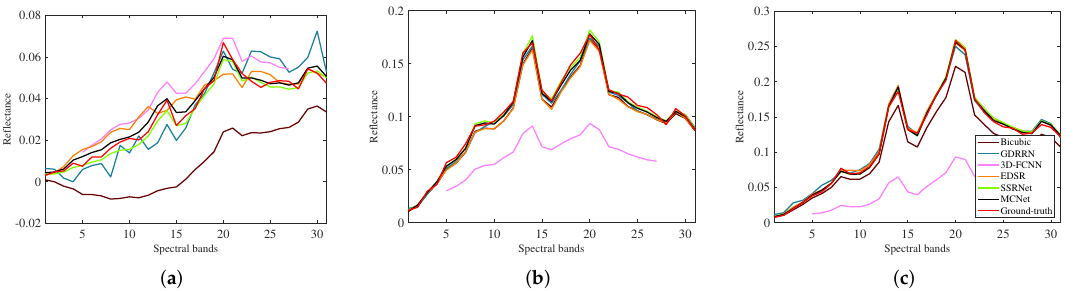
Figure 11. Visual comparison of spectral distortion for image imgd5 on Harvard dataset. ( a – c ) Results of the spectral curve in pixel position (20, 20), (100, 100), and (340,